Question: In a single sentence, describe what this figure presents.
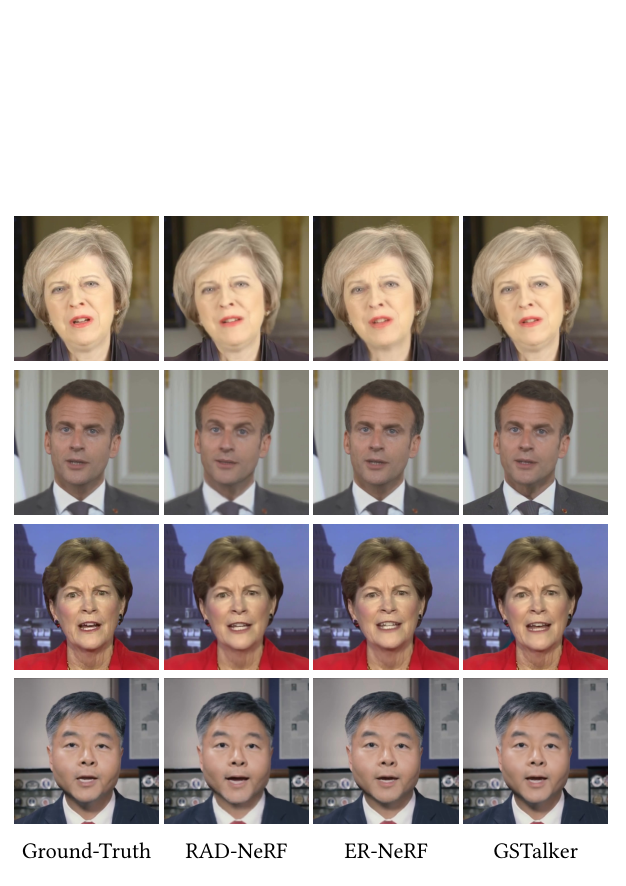
Answer: The qualitative comparison with real-time NeRF- based methods. We show more generated results compared to the real-time NeRF-based methods. These results include the performance across genders and languages in the self-driven setting.